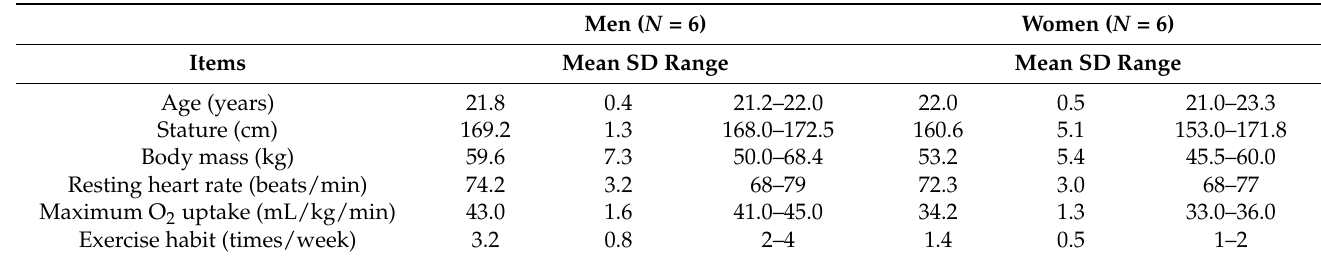
Table 1. Age, physical characteristics, and exercise habits of the